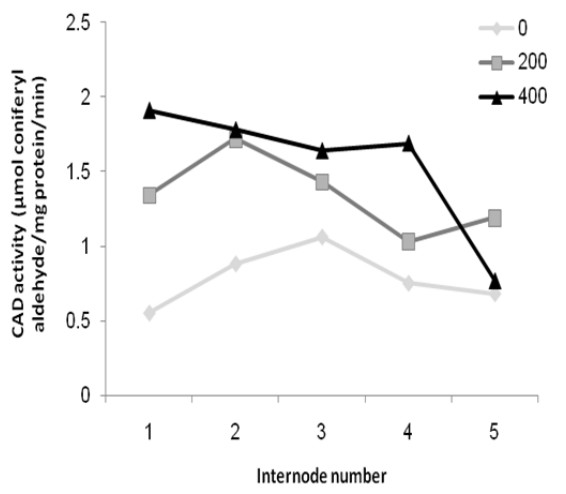
Fig. 2. Change in CAD activity under salt stress during intermodal development. 1-5 Internode number from top; 1: upper and youngest internode and 5: lower internode. NaCl treatment: 0, 200 and 400 mM